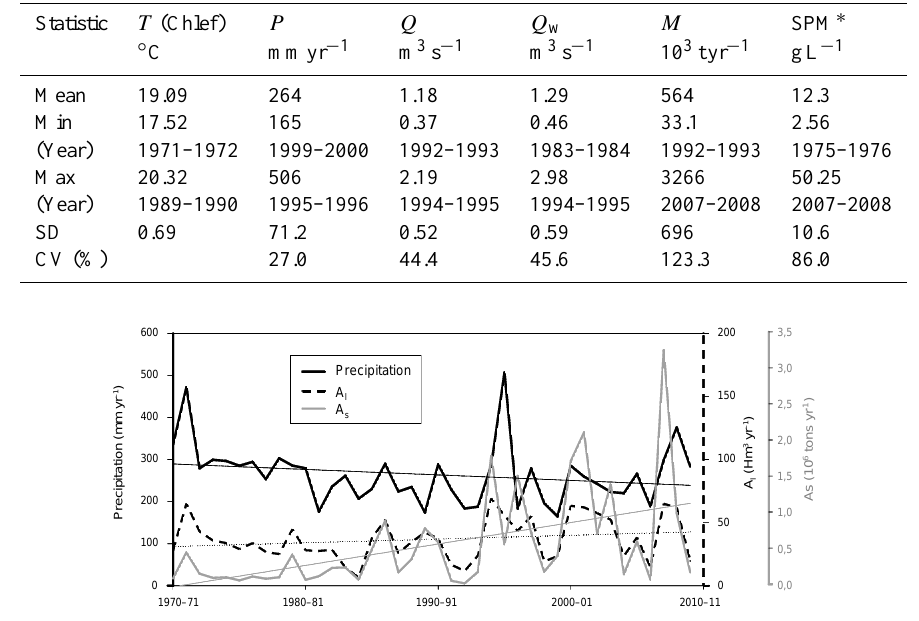
Figure 7. Interannual variations of annual precipitation, water discharge and sediment yield at Ain Hamara station.